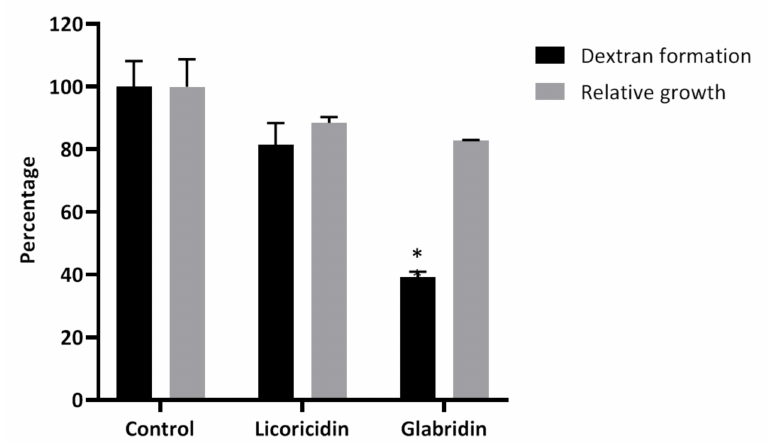
Figure 2. Effects of licoricidin and glabridin ( 1 MIC) on dextran formation by and the growth of 4 Streptococcus mutans ATCC 25175. Dextran formation was determined using Cascade Blue-conjugated dextran dye while growth was assessed by monitoring the A 660 . The assays were carried out in triplicate, and the means ± standard deviations were calculated. *, significantly different ( p < 0.001) from the control (no licorice compounds).